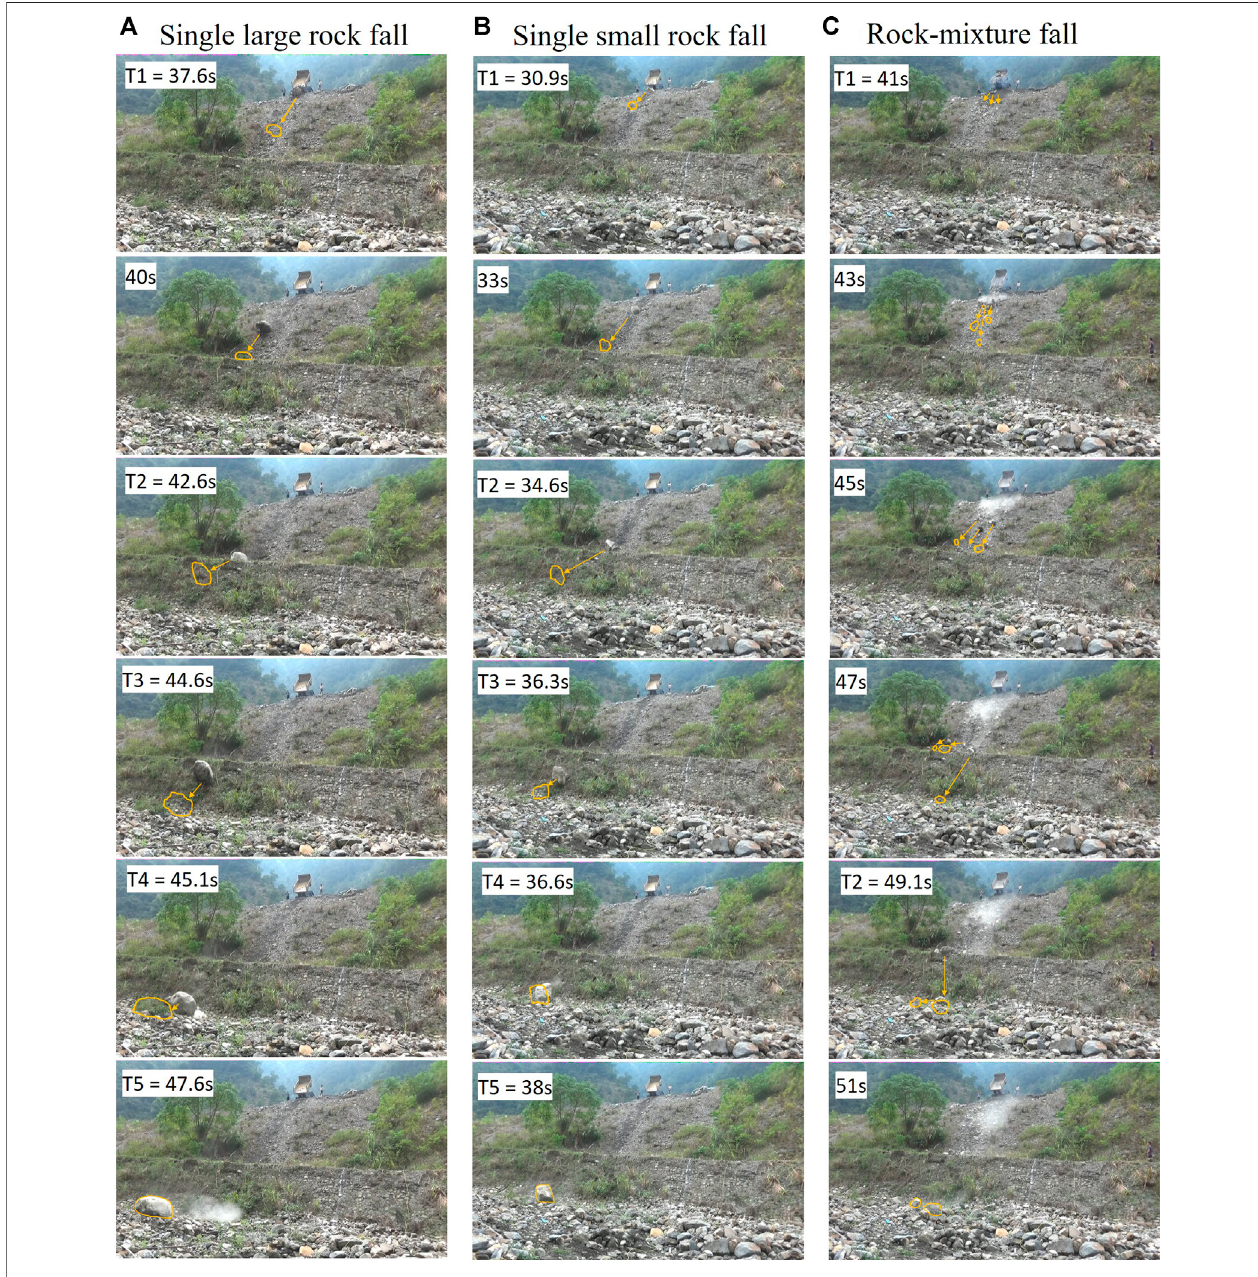
FIGURE2| Serialsnappicturesofthethree fi eldtests: (A) thesinglelargerockfall(Test2), (B) thesinglesmallrockfall(Test5), (C) therockmixturefall(Test7).(The pictures were captured from the test fi lms of Feng and Zhuang (2021). The test fi lms can be viewed at https://link.springer.com/article/10.1007/s10346-021-01748-9).